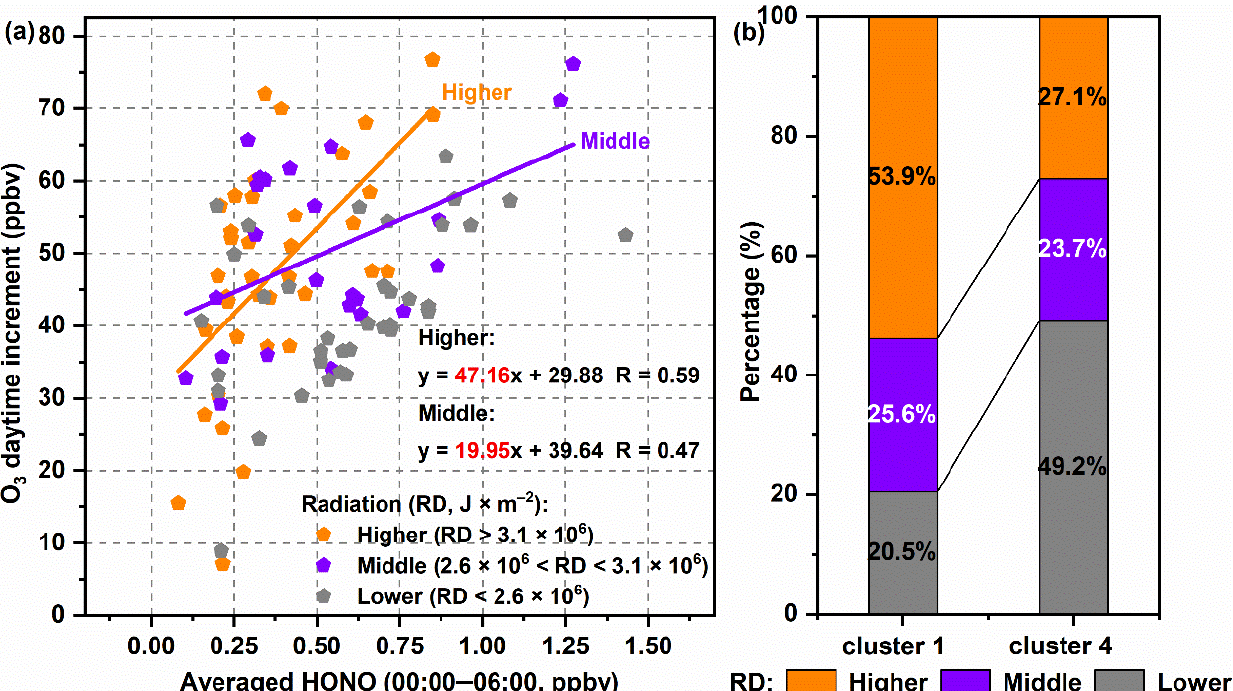
Figure 8. The dependence of the O 3 increment in clusters 1 and 4 on the HONO concentration under different radiation conditions ( a ) and the radiation distributions of clusters 1 and cluster 4 ( b ).